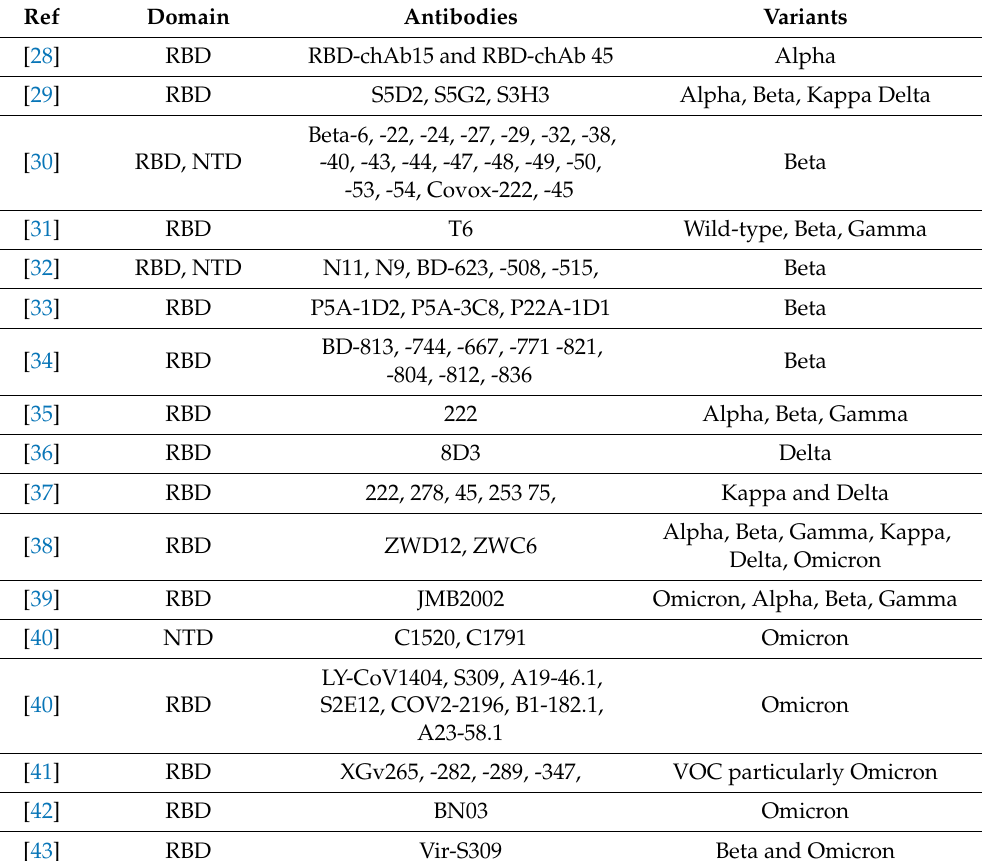
Table 5. Summary of RBD (NTD)-directed NAbs targeting the S protein of SARS-CoV-2